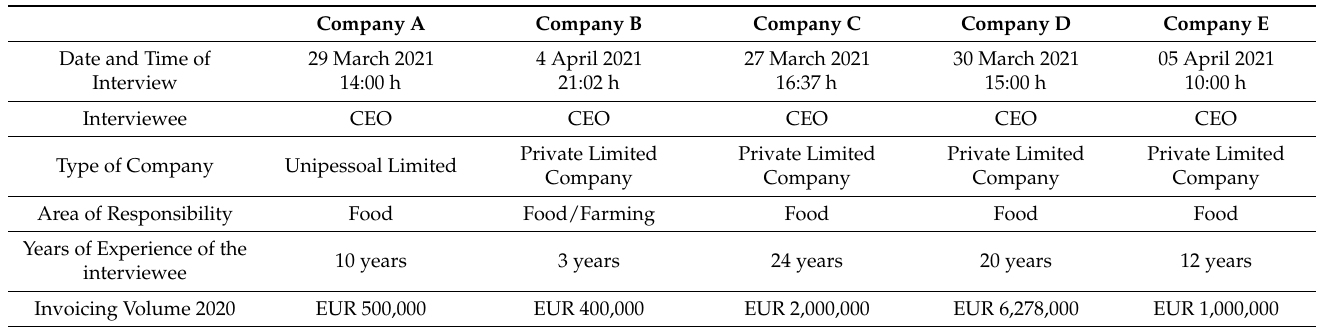
Table 2. Companies Data.